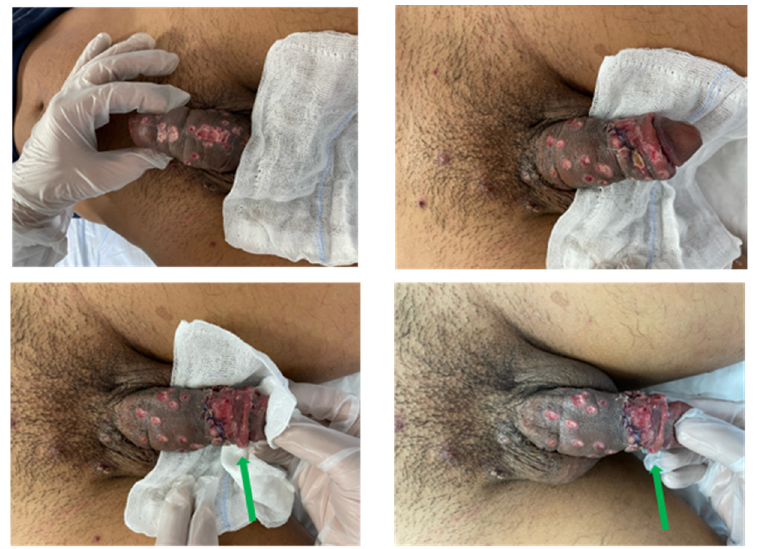
Figure 3. Photos taken 48 h after surgery: previously necrotic lesions are scarring. The largest necrotic area (indicated by the blue arrow in Figure 2) is also healing (green arrow).